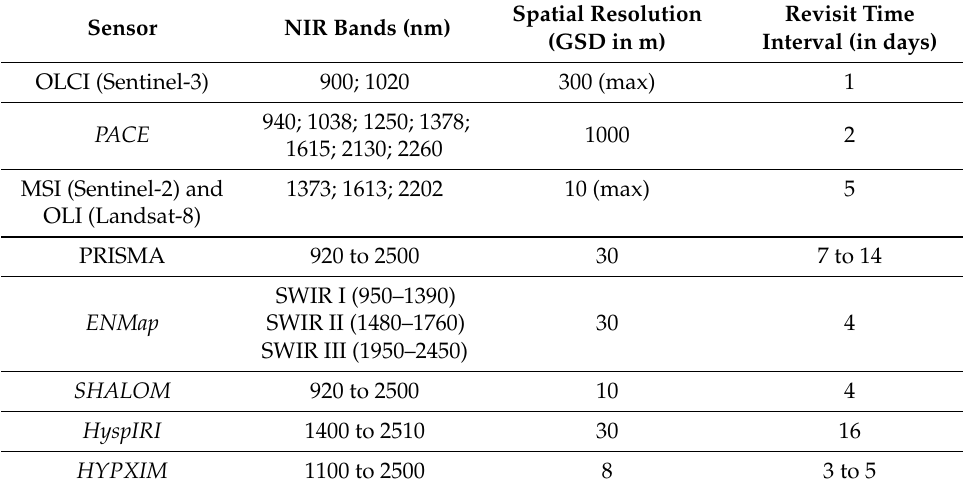
Table 2. Summary of satellite sensors and their spectral, spatial and temporal resolution characteristics. Near-infrared (NIR) bands listed close to those proposed for marine plastic debris detection. Spatial resolution is described by the size on the ground (ground sampling distance, GSD) of the minimum data unit. Temporal resolution is described by time between measurements over a given location. In italics, missions in different stages of planning, not launched